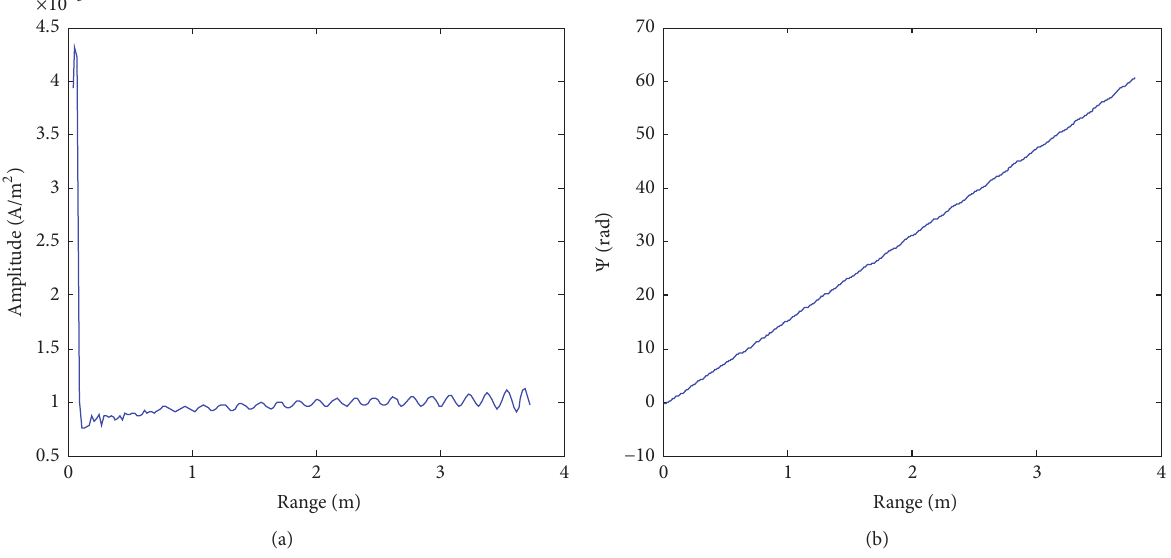
Figure 4: Amplitude and phase of the induced currents on 𝐿1 󸀠 in shadow region. (a) Amplitude; (b) unwrapped phase.